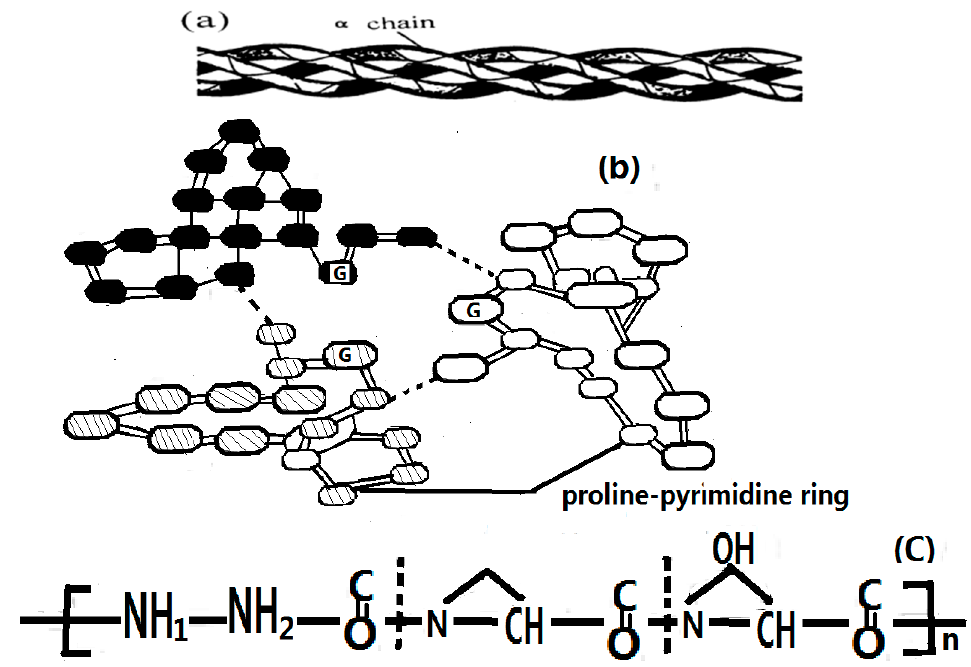
Figure 7. Molecular structure of collagen: ( a ) fundamental structure of right α -helix with three channels; ( b ) atomic distribution on top section of three channel–axes, where G is carbon atom, is hydrogen bond; ( c ) one-dimensional structure of gly-pro-hydropro.